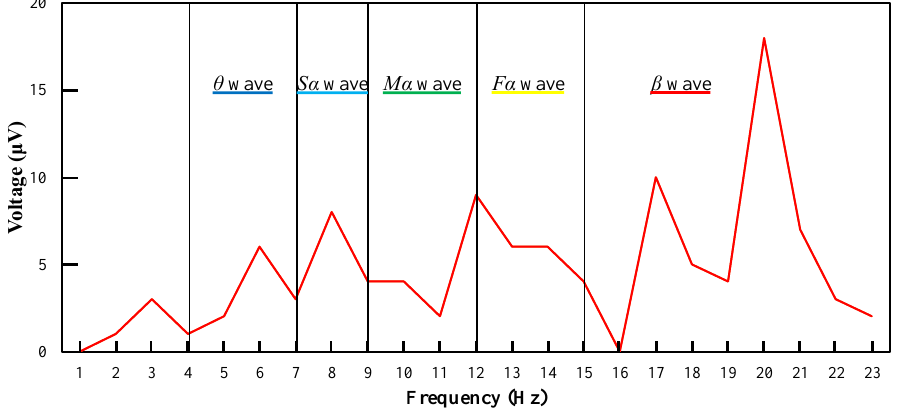
Figure 1. Brain wave meter.